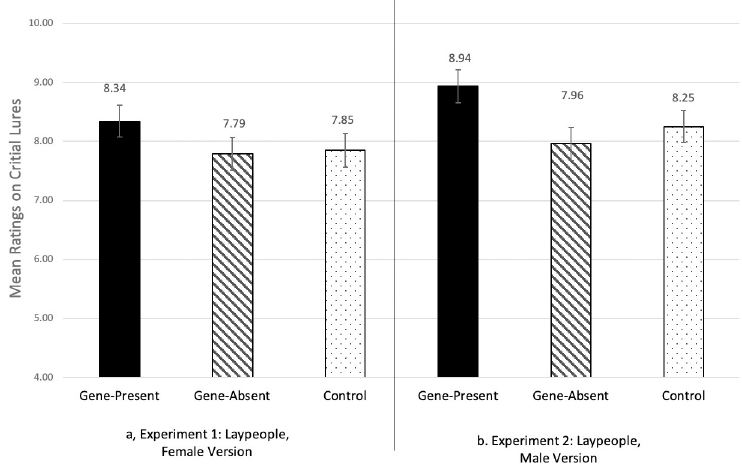
Fig 1. Critical lure scores, by condition, in Experiments 1 and 2. Higher numbers indicate greater confidence that the critical lures were present in the target vignette. Error bars reflect one standard error.